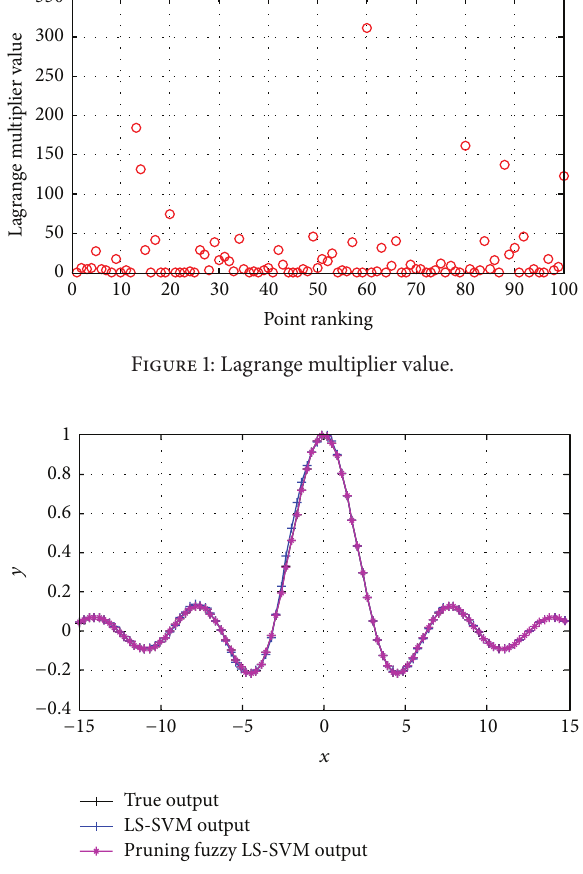
Figure 2: Prediction output of one-dimension